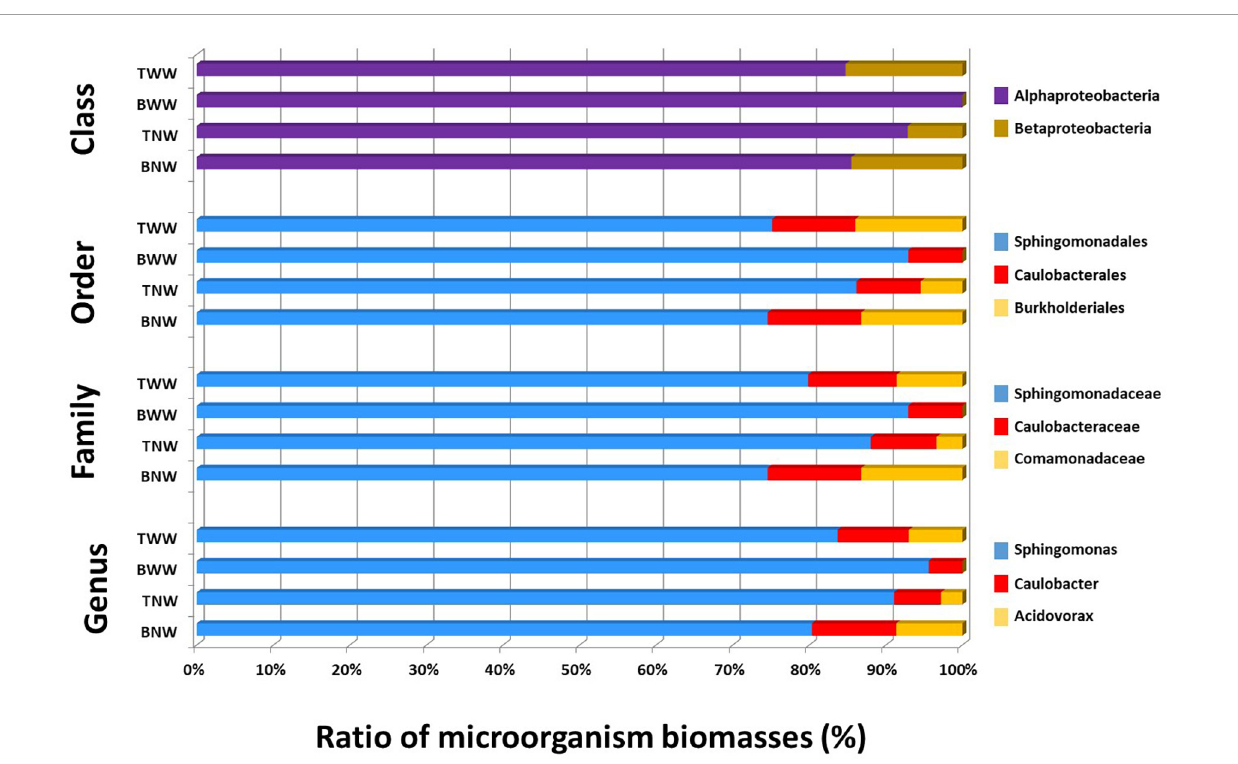
FIGURE3 Proportion of each genus in the four biofilms after phylopeptidomic analysis. Biofilms were recovered from four locations (TWW, BWW, TNW, and BNW). The ratios of microorganisms were established either by Class-specific TSMs, Order-specific TSMs, Family-specific TSMs or Genus-specific TSMs for the four